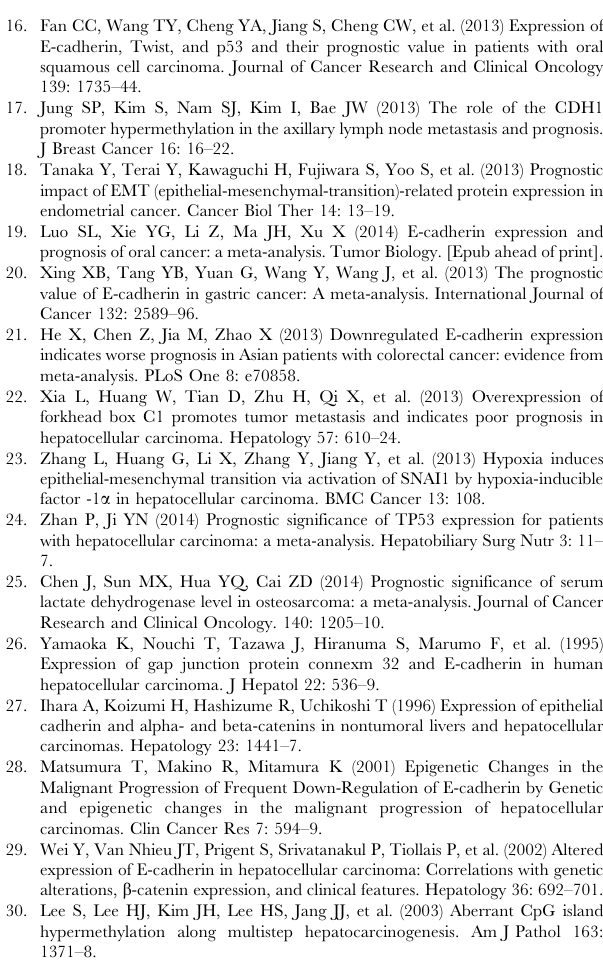
Figure S3 Funnel plot to assess publication bias. Begg’s publication bias plot showed the presence of publication bias for studies regarding reduced E-cadherin expression and differentia- tion grade in the meta-analysis. Figure S4 Funnel plot to assess publication bias. Begg’s publication bias plot showed the presence of publication bias for studies regarding reduced E-cadherin expression and metastasis in the meta-analysis. Figure S5 Funnel plot to assess publication bias. Begg’s publication bias plot showed no publication bias for studies regarding reduced E-cadherin expression and vascular invasion in the meta-analysis. Figure S6 Funnel plot to assess publication bias. Begg’s publication bias plot showed the presence of publication bias for